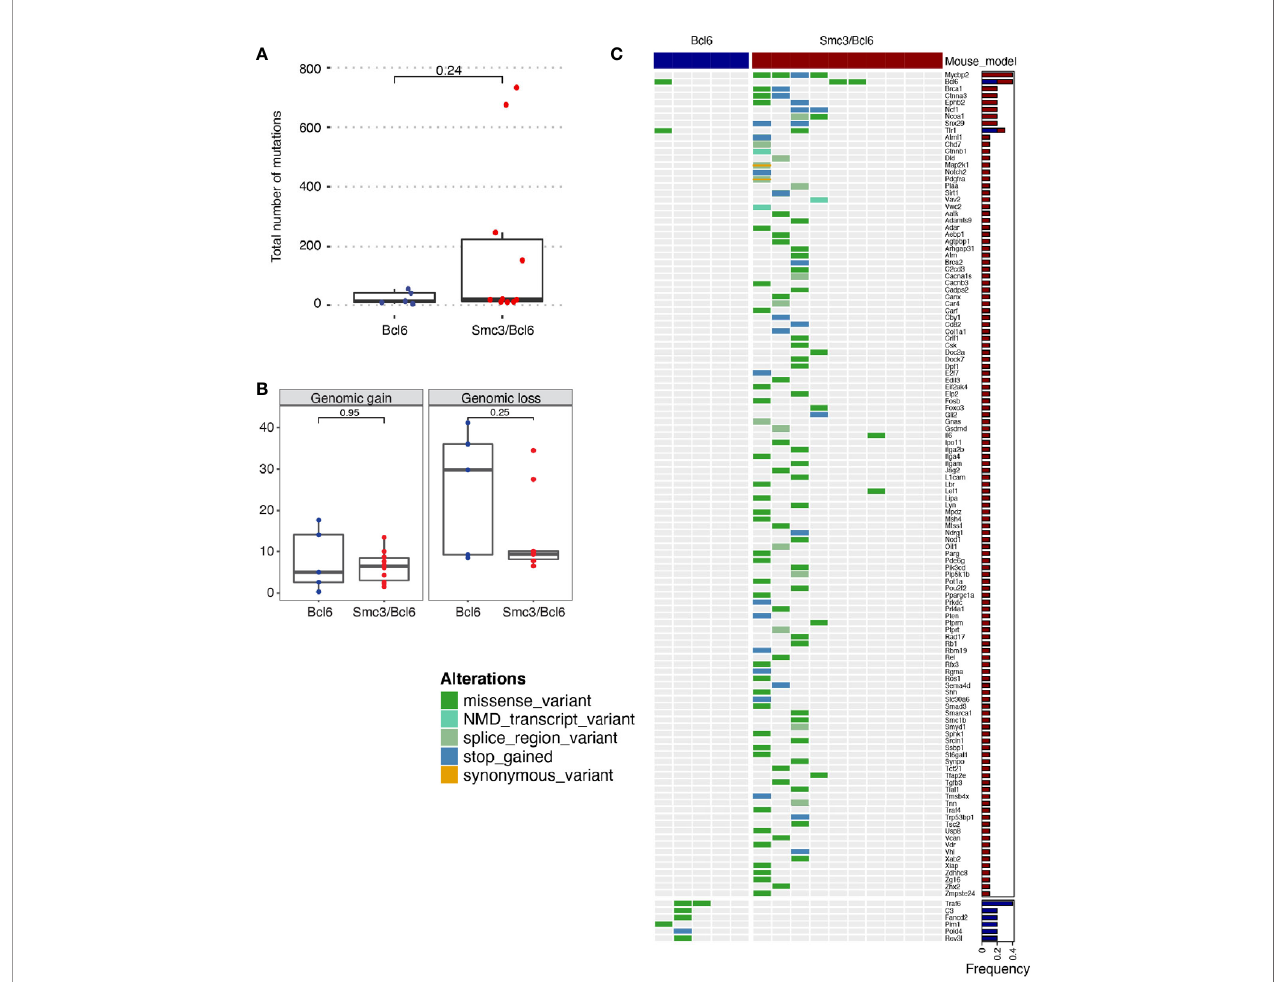
FIGURE 5 | Mutational analysis of Smc3/Bcl6 tumors. (A, B) Mutational burden of Bcl6 and Smc3/Bcl6 tumors assessed by exon capture analysis. (A) number of mutations per tumor. (B) Genomic gain and loss in Bcl6 and Smc3/Bcl6 tumors. (C) Oncoprint depicting AID-induced mutations in 125 non-immunoglobulin genes in Bcl6 (n=5) and Smc3/Bcl6 (n=10) tumors. Mutation frequency is shown in the right bar plot for Bcl6 (blue) and Smc3/Bcl6 (red). Mutations were classi fi ed as missense mutations, nonsense-mediated decay transcript variants, splice regions variants, stop gained, or synonymous variants, as indicated by the color key on the left of the